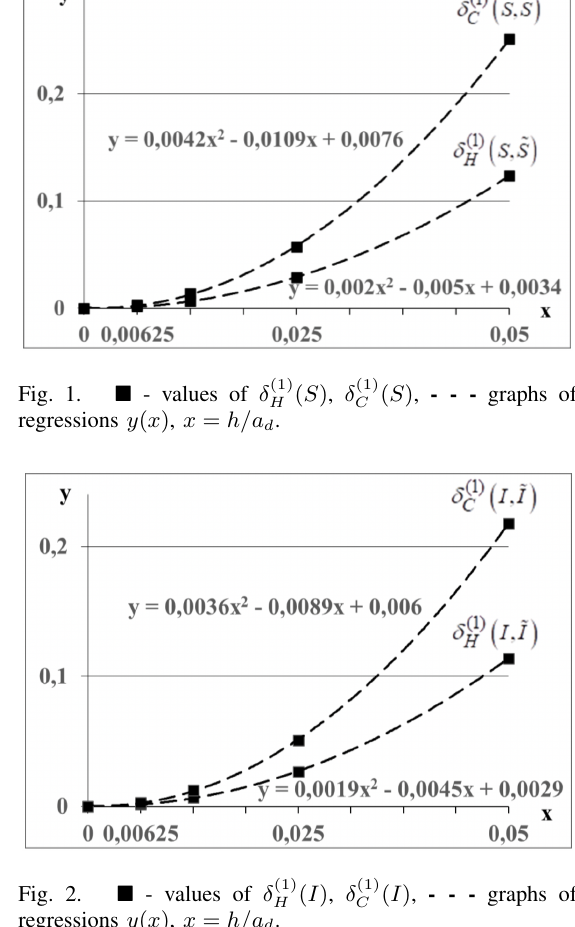
T HE VALUES OF δ (1)